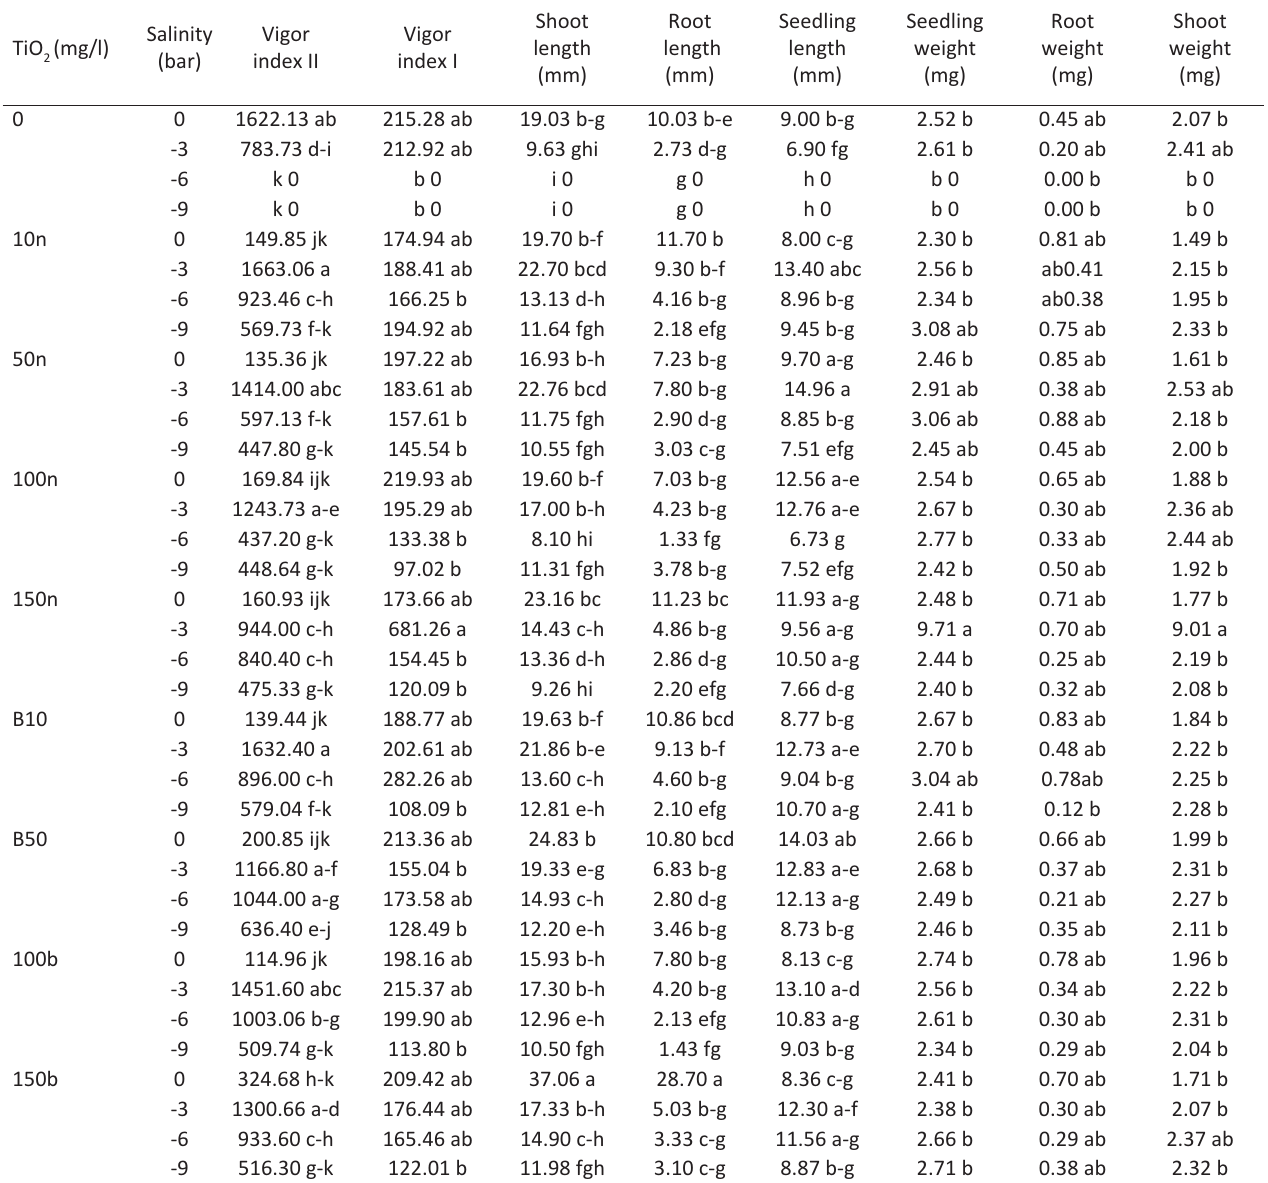
Table 5 ­ Interaction effect of titanium dioxide particles and salinity on seedling traits of Echinacea